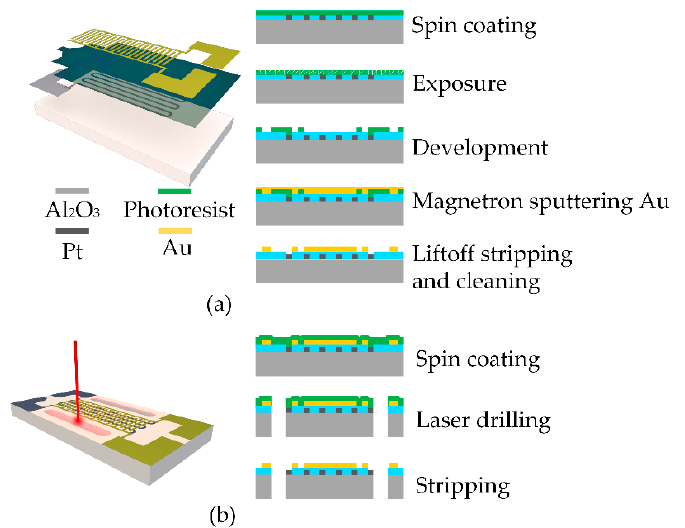
Figure 6. ( a ) Process flow of interdigital electrodes preparation. ( b ) Process flow of laser processing.